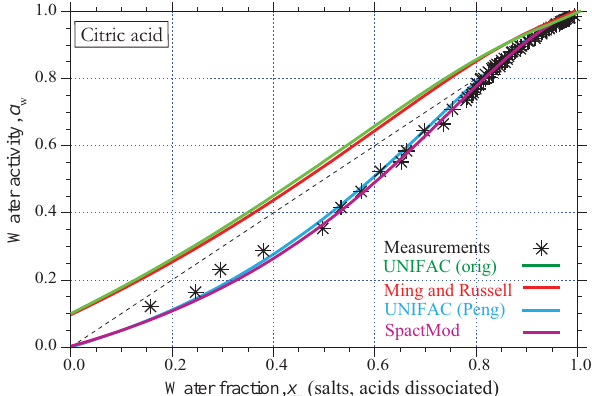
Figure 6. Intercomparison between selected models for Ca(NO 3 ) 2 salt: Water activities (solid lines) and mean activity coefficients (dashed lines). Again, SpactMod reproduces AIOMFAC.